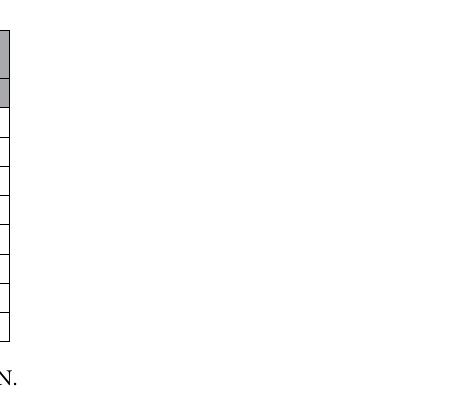
Table 3. Multivariate logistic regression analysis for